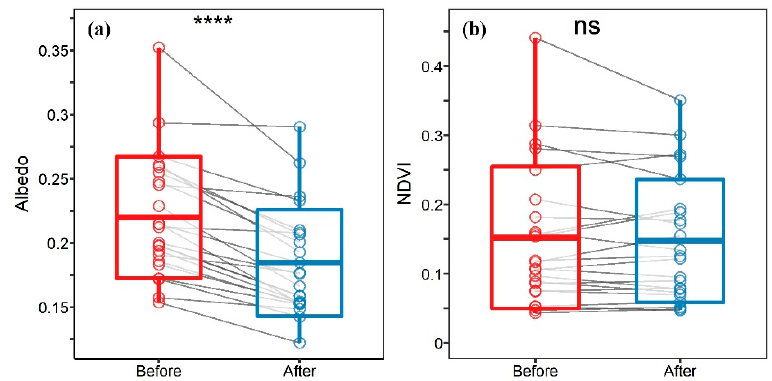
Figure 6. The surface condition changes due to the installation of the PV powerplants, ( a ) the albedo and ( b ) the NDVI of PV powerplants before (red part) and after (blue part) the installation of the PV powerplants, paired t-test was used to determine the difference of the two groups. The gray line connected the paired points; ns, *, **, ***, and ****: statistically significant at p > 0.05, p < 0.05, p < 0.01, p < 0.001, and p < 0.0001 levels.